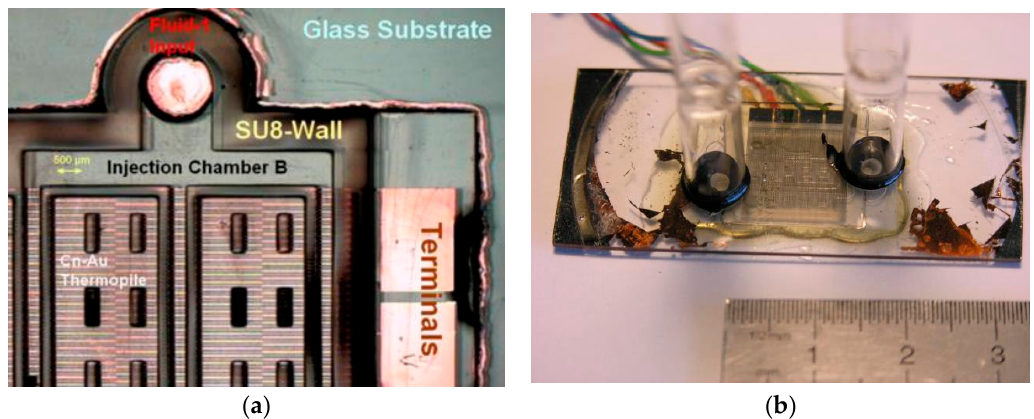
Figure 3. ( a ) Layout of the prototype highlighting: the glass substrate ( λ th = 1 W/mK), the Au- Constantan plated planar thermopile (N = 360), the SU8 walls 400 µm in height allowing to drive and mix both fluid-constituents, and the electrical terminals; ( b ) Global view of the device with both fluids inputs: the output being on the other side is here